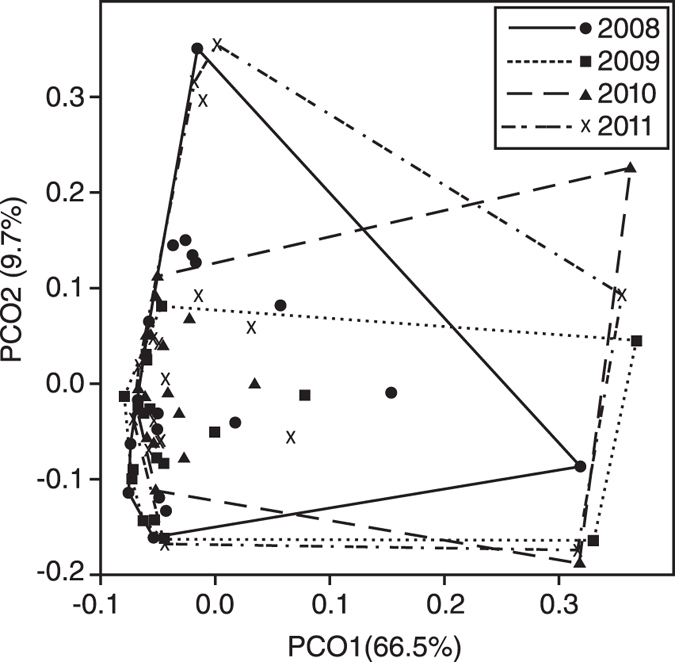
Principal Coordinates Analysis biplot for foraminiferal assemblages from Heron Reef flat.Symbols represent sample sites. Convex hulls outline each of the four sampling intervals (2008–2011). Numbers in brackets indicate % variance attributed to that axis.